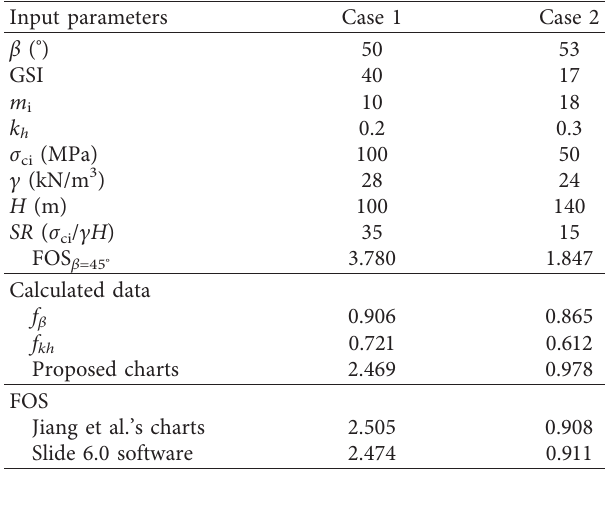
Table 5: Case studies of rock slope analyzed using the proposed seismic stability